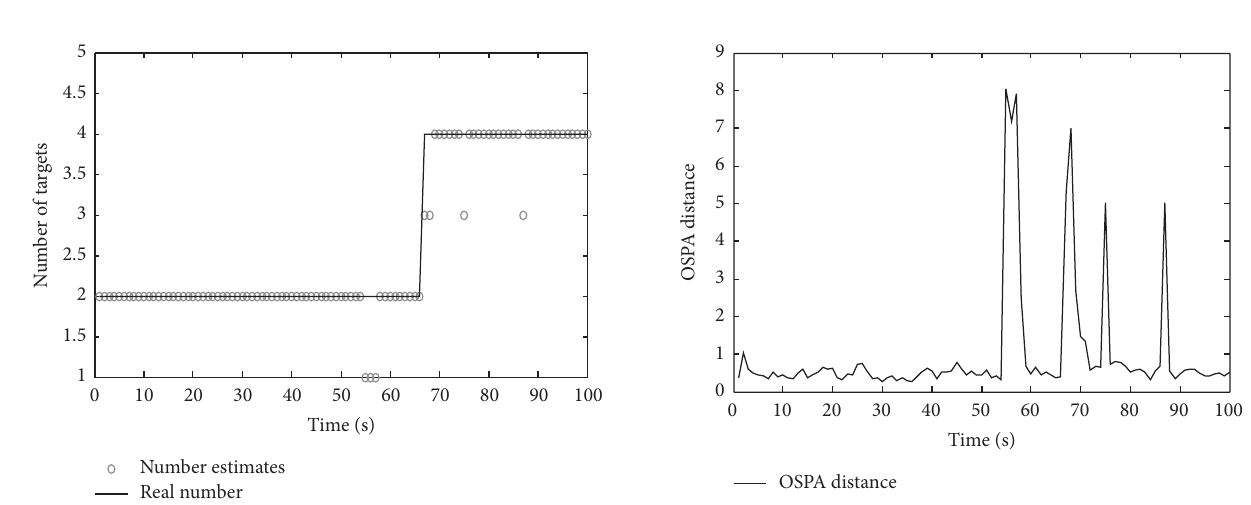
Figure 8: Shape estimate results.